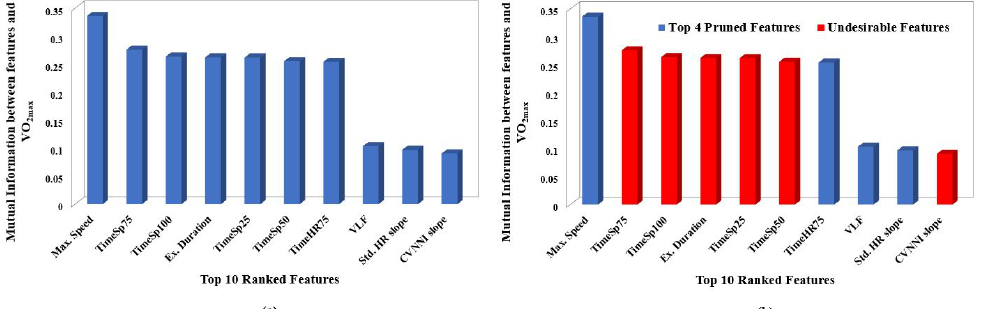
Figure 4. Plots depicting ranking and pruning performed based on mutual information. Each sub plot shows: ( a ) Mutual information between VO 2 max and top 10 ranked features associated with exercise data. ( b ) Undesirable features removed based on Spearman’s correlation coefficient of exercise